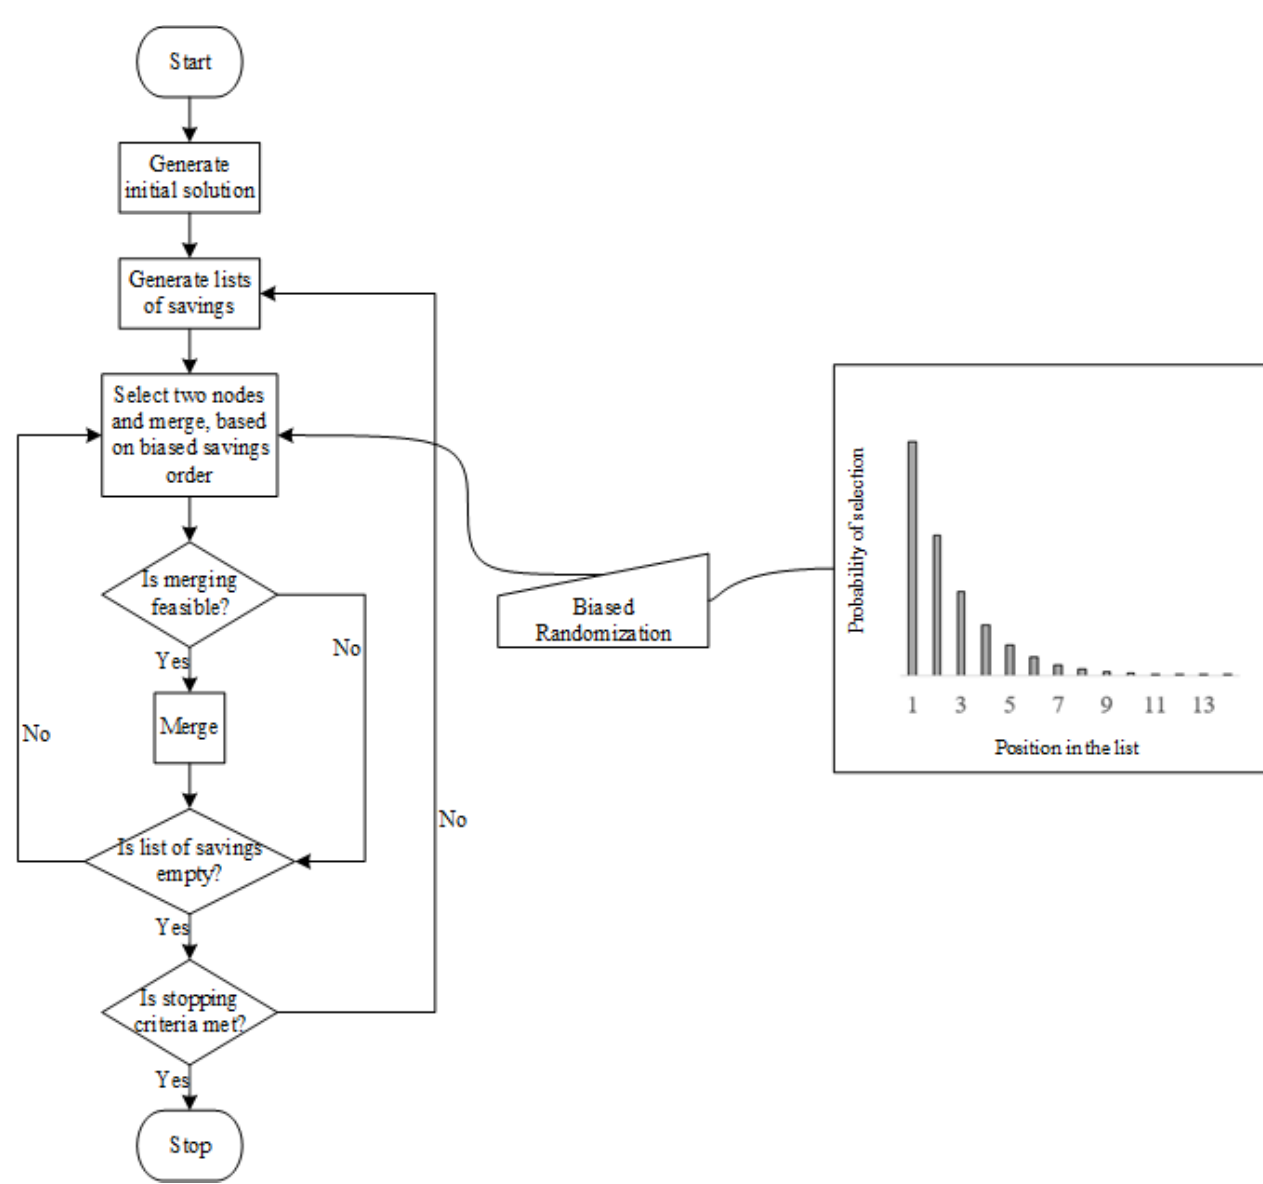
Figure 5. Flowchart of the proposed algorithm for solving the Vehicle Routing Problems